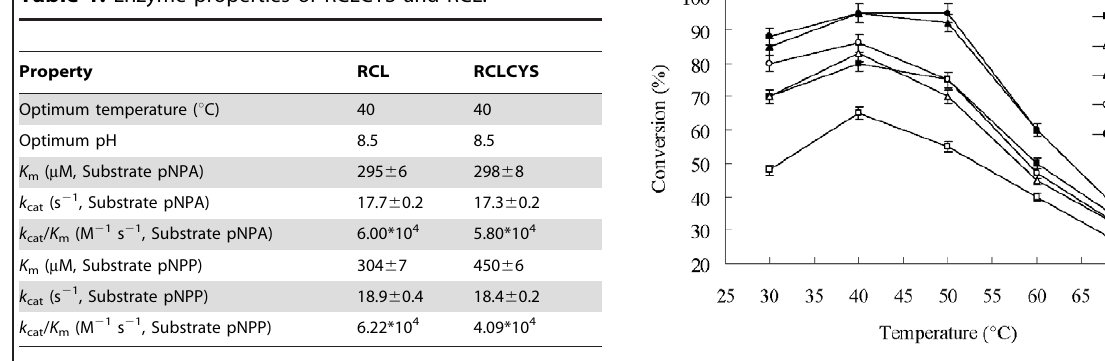
Table 1. Enzyme properties of RCLCYS and RCL.